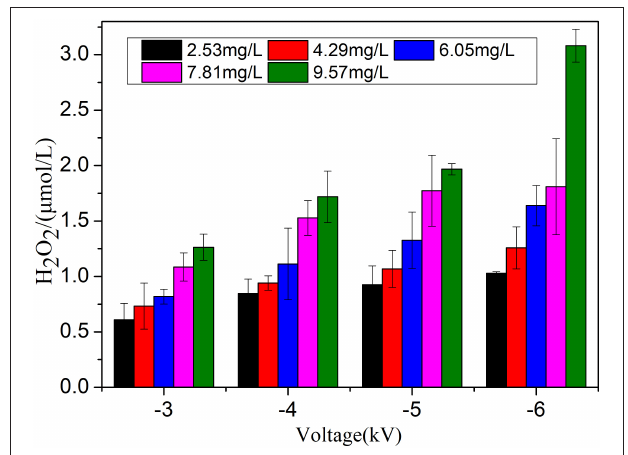
FIGURE 13 | Variations of the germination inhibition rate and the sporoderm-breakage rate with the water content and the treatment time under − 6 kV voltage, 10min response time, and 5min storage